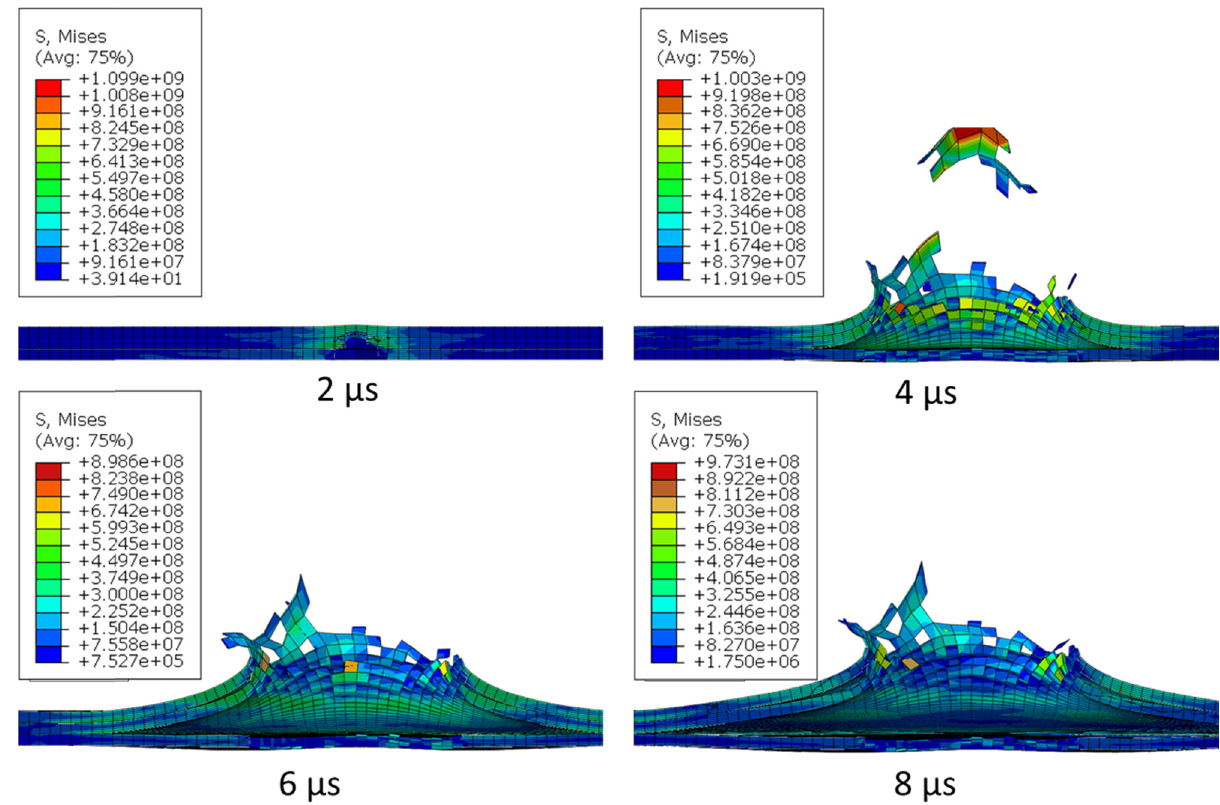
Figure 9: Stress distribution and deformation for model 3 against ogive